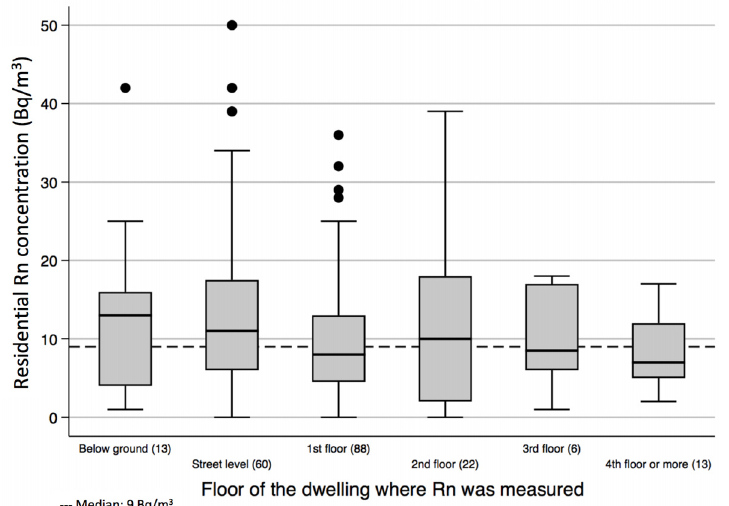
Figure 4. Residential 222 Rn concentrations according to the height of the measurement site. Mani-